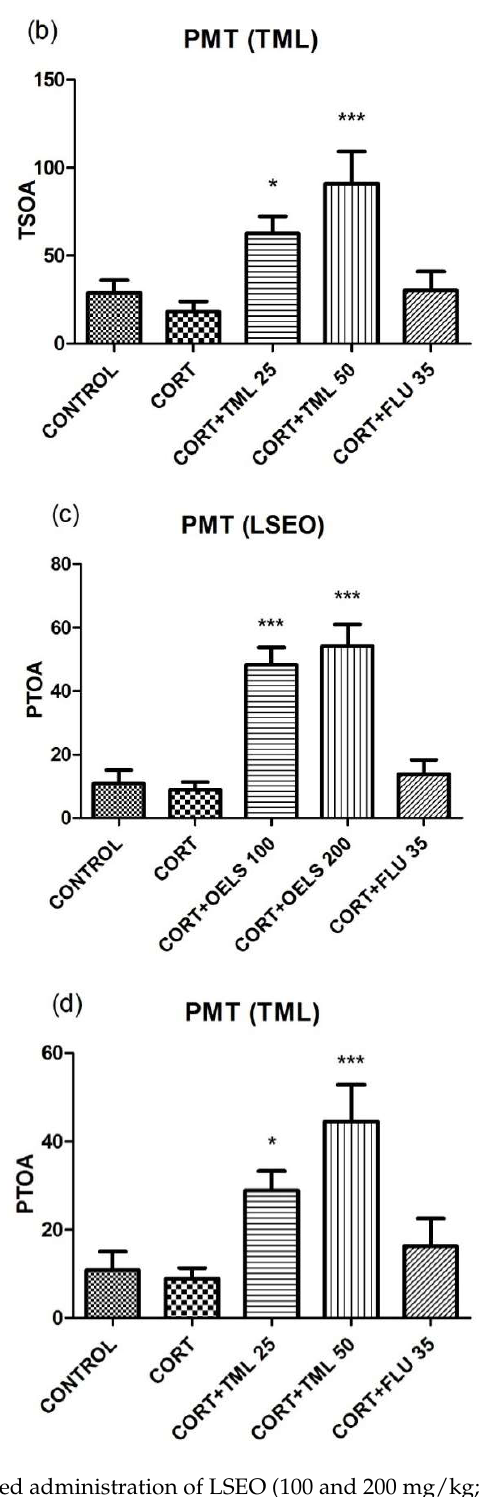
Figure 9. Effects of repeated administration of LSEO (100 and 200 mg/kg; p.o.) on the TSOA ( a ) and PTOA ( c ) and TML (25 and 50 mg/kg; p.o.) on the TSOA ( b ) and PTOA ( d ) in animals treated with CORT (22 days, 20 mg/kg, s.c.) in the plus maze test. Values are expressed as the mean ± SEM ( n = 10). Statistical analysis was determined by one-way ANOVA followed by the Student-Newman-Keuls test. Significant values: * p < 0.05, ** p < 0.001, *** p < 0.0001 vs. CORT. LSEO = Lippia sidoides essential oil; TML = thymol; CORT = corticosterone; PMT = plus maze test.